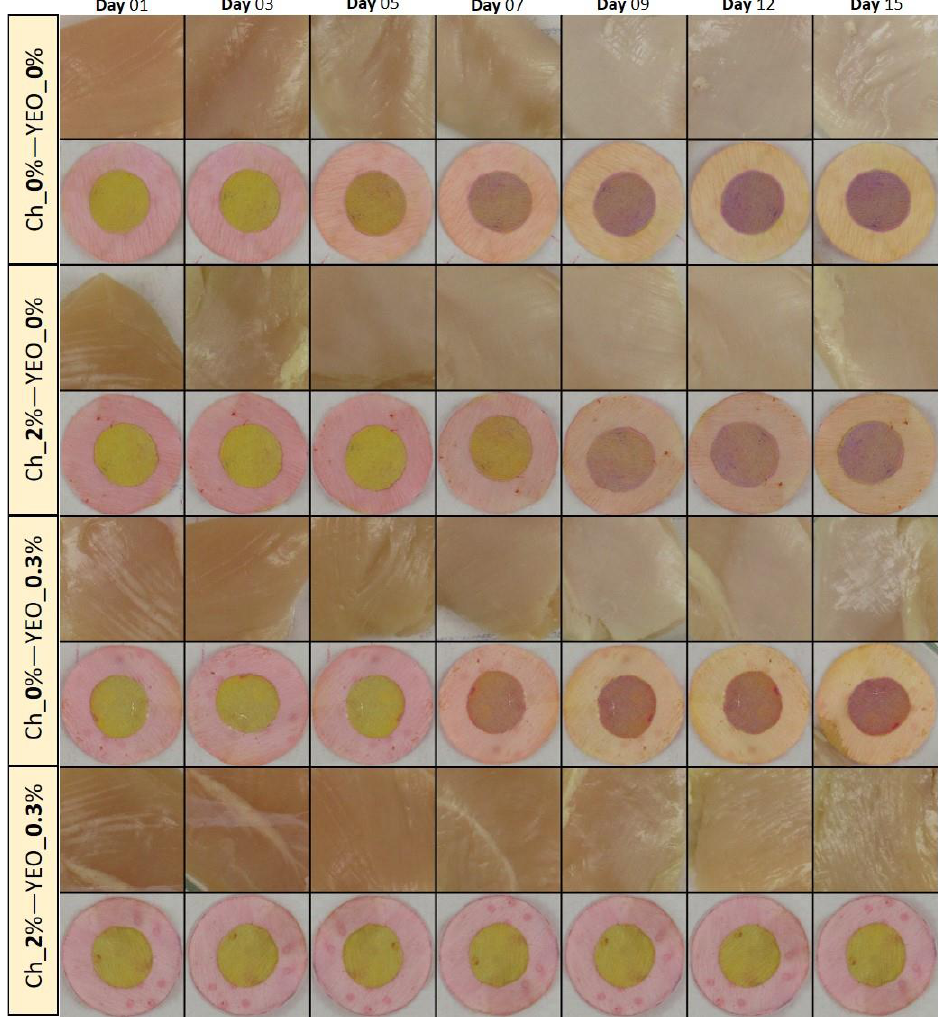
Figure 3. Visual inspection of the color of chicken meat samples and their attached sensor labels: effect of different types of coating and chilled storage time.